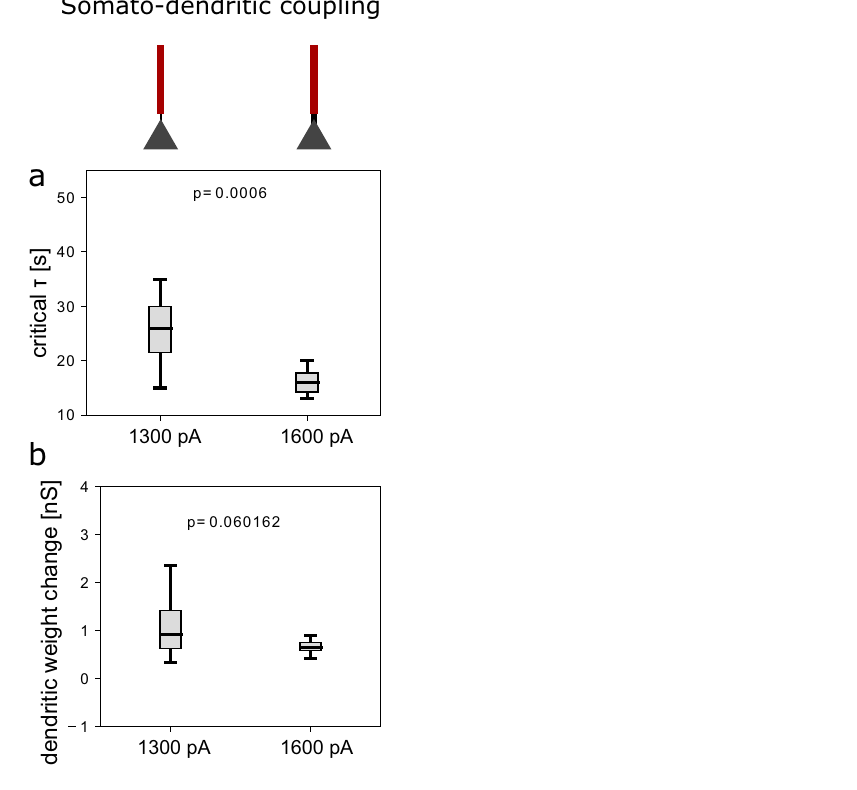
Figure 4. Effect of somato-dendritic coupling. ( a , b ) Effect of the dendrite-to-soma coupling, determined by g s , i.e. how much the dendritic nonlinearity affects the soma. ( a ) Distribution of critical homeostatic time constants for a dendro-somatic coupling of 1300 pA (default) versus 1600 pA. ( b ) Distribution of dendritic weight changes for a dendro-somatic coupling of 1300 pA (default) versus 1600 pA. The rectangles represent the interquartile range (IQR) between first and third quartiles. The thick horizontal lines represent the medians. The whiskers indicate the lowest and highest values within 1.5xIQR from the first and third quartiles, respectively. The circles denote outliers. p-values were obtained by using the two-sample student’s